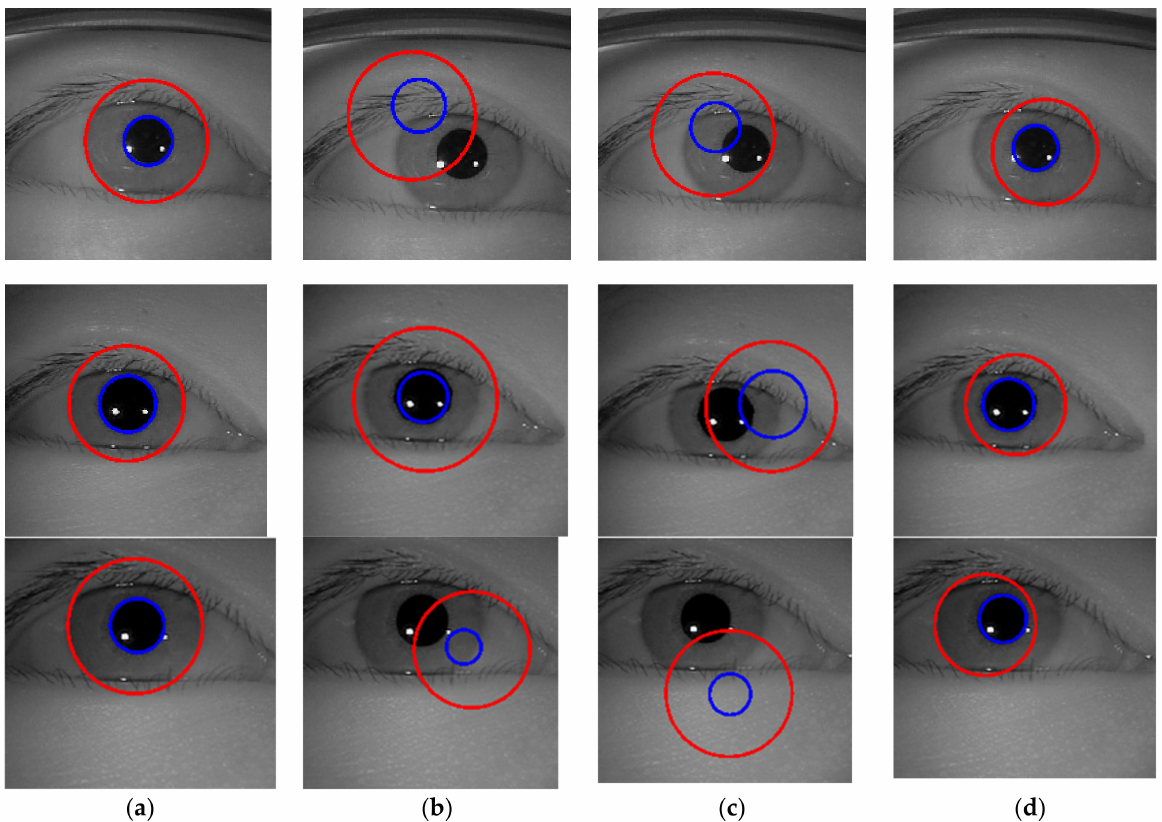
Figure 12. Outer and inner boundary estimation comparison of the proposed method with other works on challenging image. ( a ) Proposed method; ( b ) Li et al. [4]; ( c ) Li and Huang [8]; ( d ) Duda and Hart [46], respectively.